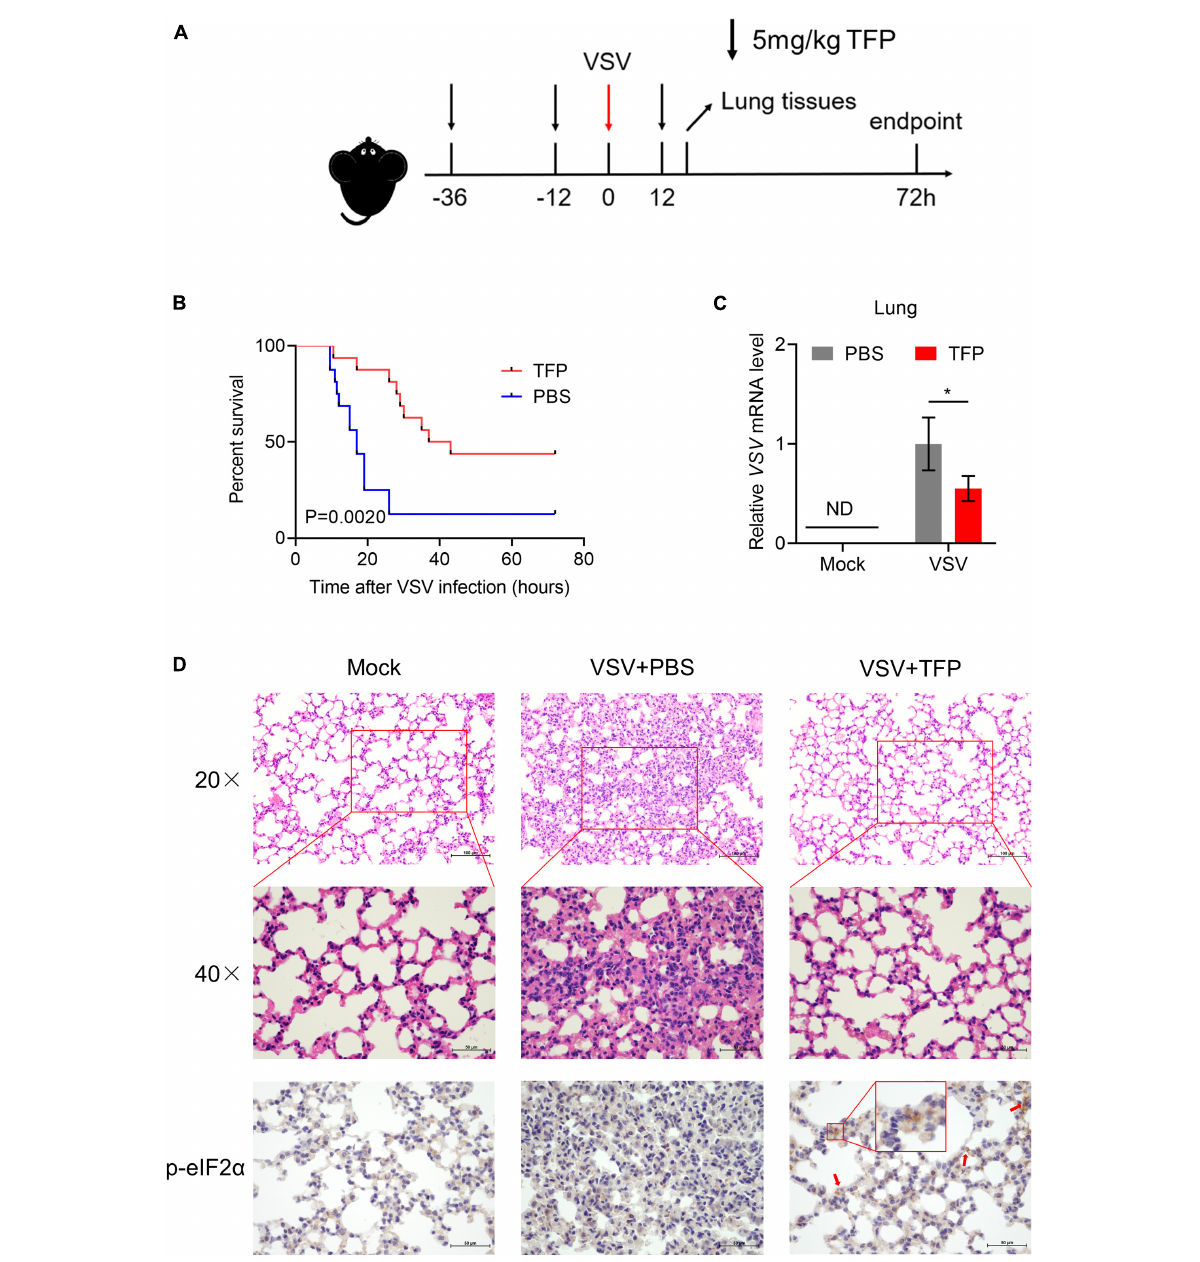
FIGURE5 TFP protects mice from lethal VSV attack. (A) Schematic of VSV attack model in C57BL/6J mice with TFP treatment. Hours are indexed based on the time of VSV i.v. injection. Mice received 5 mg/kg TFP or equal volume PBS twice before VSV infection by intraperitoneal injection. TFP was administered 12 h after the VSV attack again. Lung tissues were harvested 18 h after the VSV attack. For survival experimental studies, the observation endpoint was 72 h. (B) Survival curves ( n = 16 mice per group, Log-rank test) of 6- to 8-week-old C57BL/6J mice infected with VSV (4 × 10 6 PFU/g) via tail i.v. injection. (C) qPCR analysis of relative VSV mRNA level in lung from mice corresponding to panel (A) . (D) Images of H&E staining and IHC of lung sections from the mice shown in panel (A) . Scale bars, 50 µ m or 100 µ m. * p < 0.05 (one-tailed Student’s t